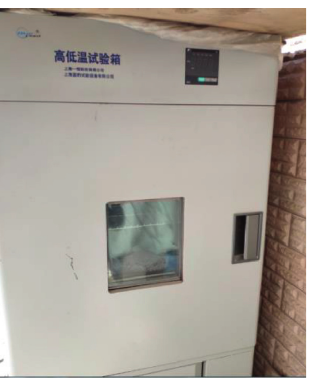
Figure 3: High and low temperature test chamber.